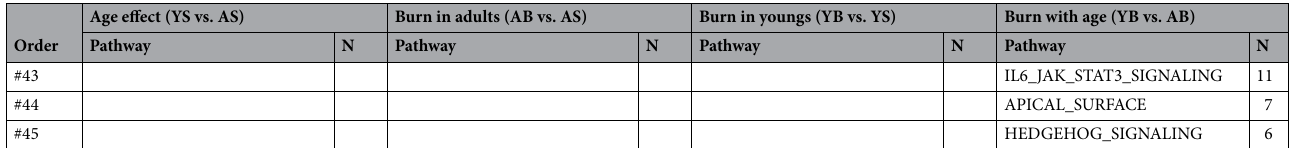
Table 2. Hallmark gene sets analysis in mouse gastrocnemius between young sham (YS), young burn (YB), adult sham (AS), and adult burn (AB) groups. Hallmark gene sets summarize 50 specific well-defined biological processes, which were generated by a computational methodology based on identifying overlaps between gene sets in other MSigDB collections and retaining genes that display coordinate expression. N, The number of altered